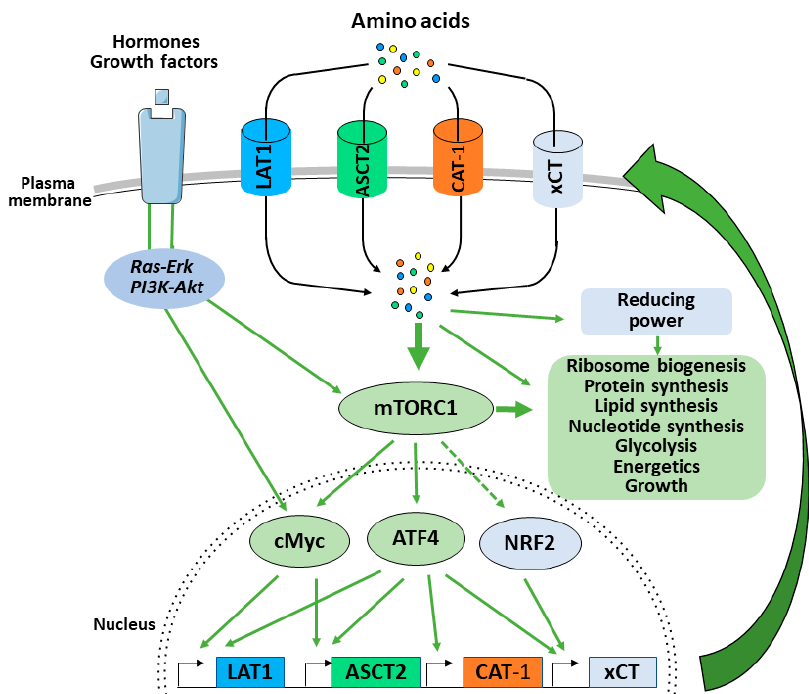
Figure 4. mTORC1 balances supply and demand by promoting amino acid uptake. When activated by growth factor, mTORC1 promotes the translation of cMyc, ATF4 and potentially stabilizes NRF2. These transcription factors will then promote the expression of AA transporters that will increase AA uptake, sustain mTORC1 activity and promote the mTORC1 mediated anabolic program and cell growth.